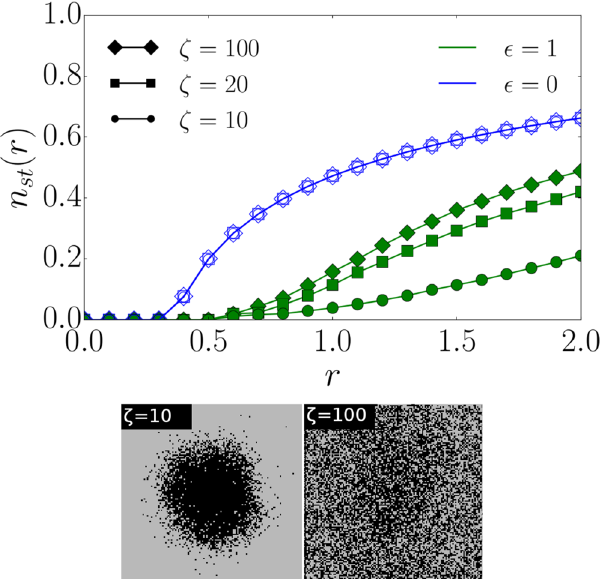
Figure 5. Transition from a lattice to a random network. (upper panel) The dependence of n r ( ) network with = × N 128 128 nodes for different values of ζ . Targeted recovery with ε = 1 (green filled markers) outperforms random interventions where ε = 0 (blue hollow markers) for all values of ζ since a smaller fraction of nodes is infected in the stationary state. The curves for ε = 0 and different ζ lie on top of each other. (lower panel) Snapshots at = t 10 for ζ = 10, 100 , = r 2 and an initial spreading seed with a radius of 30 on a network with = × N 128 128 nodes. Black lattice sites are